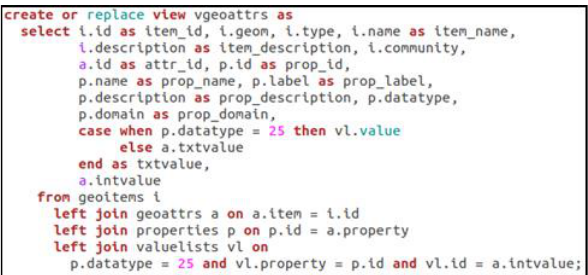
Figure 2 : SQL code for creating the view vgeoattrs to allow easy access to the generic representation Based on this view, QGIS layers can be easily created by using the filter functionality of QGIS.